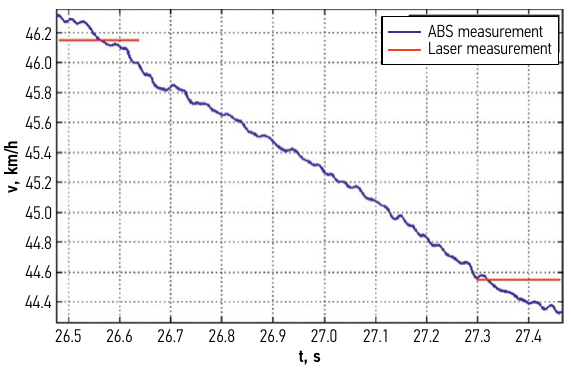
Fig. 10. Experimental ABS sensor data, car velocity on gravelled road ABS measurement, r. wheel ABS measurement, l. wheel Laser